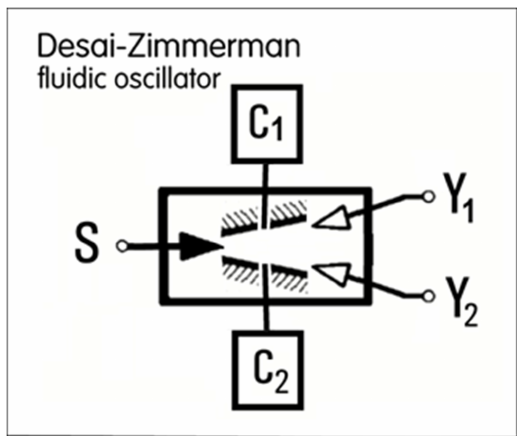
Figure 7. Schematic representation of the new D-Z oscillator developed at the University of Sheffield, U.K. [23] specially for co-operation with microbubble generating aerators. Of the two-sided relaxation type [24], its two accumulation chambers C 1 , C 2 connected to the middle of attachment walls are filled by pressure air in alternating manner.